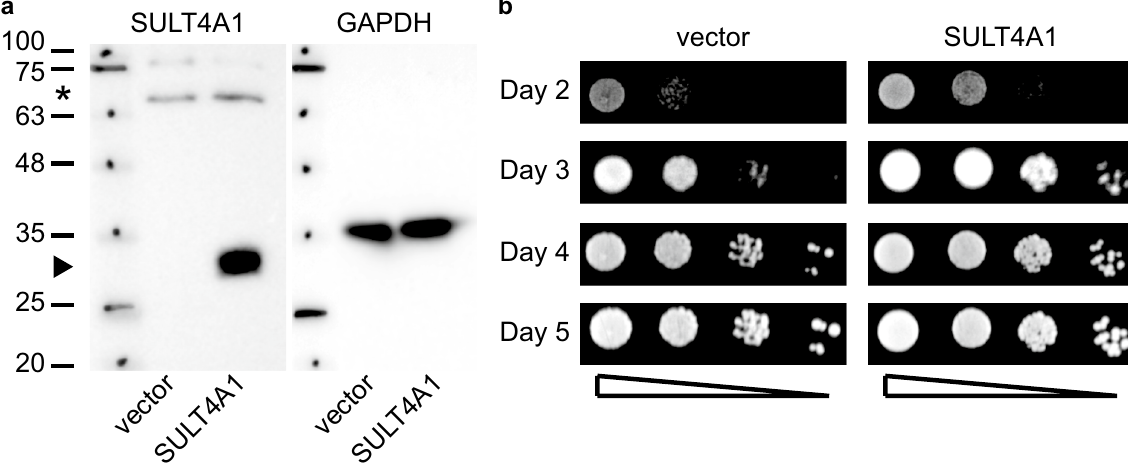
Figure 1. SULT4A1 expression in yeast stimulates colony formation. Galactose induced exponentially growing yeast cells transformed with YCpGAL1 SULT4A1 •L (SULT4A1) or control (vector) were used for ( a ) isolation of total cell extracts. 20 μg of protein of each were resolved via SDS-PAGE and transferred to a PVDF membrane, immunostained for SULT4A1 followed by stripping and immunostaining for loading control proteins; GAPDH- cytosol. Arrowhead points at SULT4A1, *non-specific staining of anti-SULT4A1 antibody. Protein ladder with sizes in kDa. ( b ) Cell cultures from yeast transformants ( a ) were corrected to OD 595 = 0.3, ten-fold serially diluted and spotted onto 2% galactose selective media plates and incubated at 30 °C. Growth was recorded from day 2 to 5. Shown is a representative result from at least 3 independent